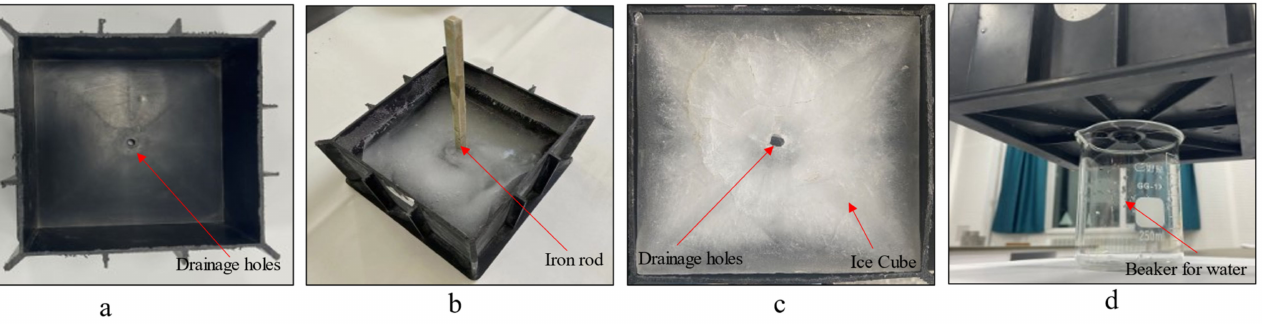
Figure 2. Preparation of ice cubes, ( a ) a mold for the preparation of ice cubes; ( b ) ice cubes taken from the freezer; ( c ) front of the ice cube with the thin iron bar removed; ( d ) a beaker for measuring meltwater is placed beneath the